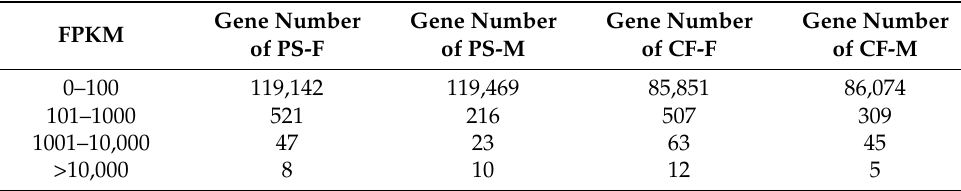
Table 1. The distribution of genes according to the expression level FPKM.